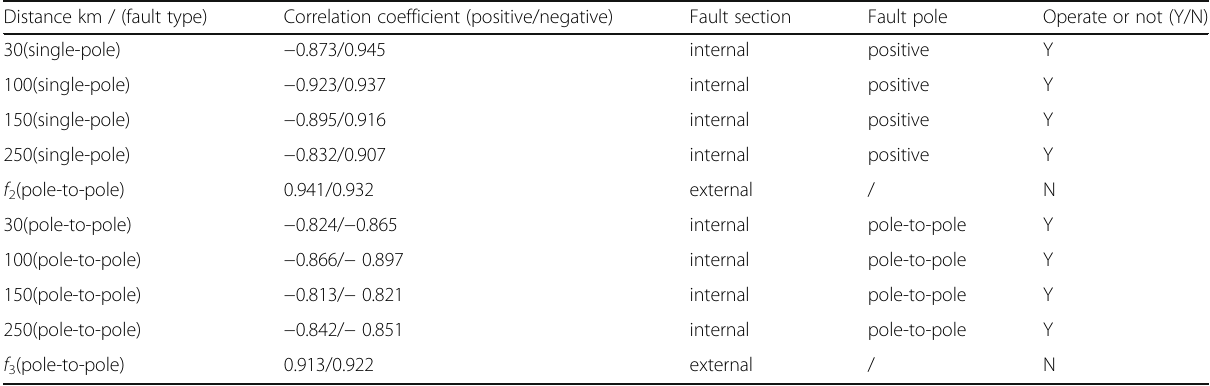
Table 2 Protection results under noise